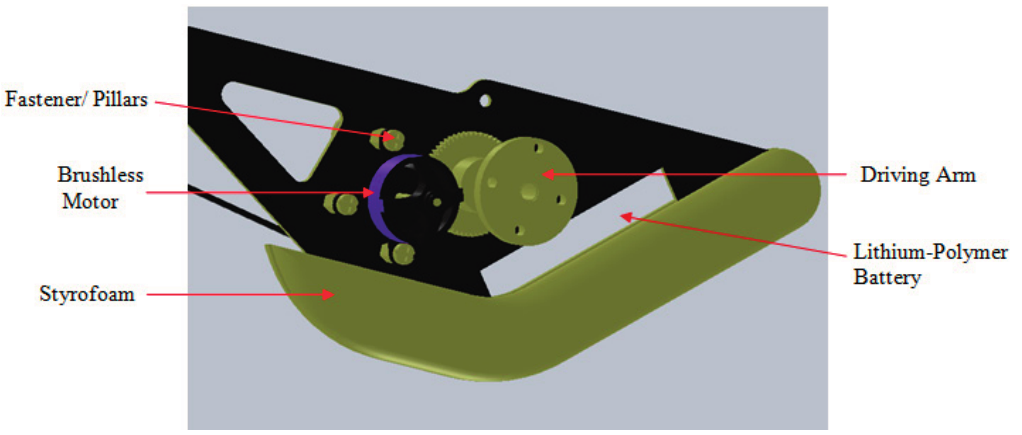
Figure 16. Right side view of flapping mechanism (CAD model).